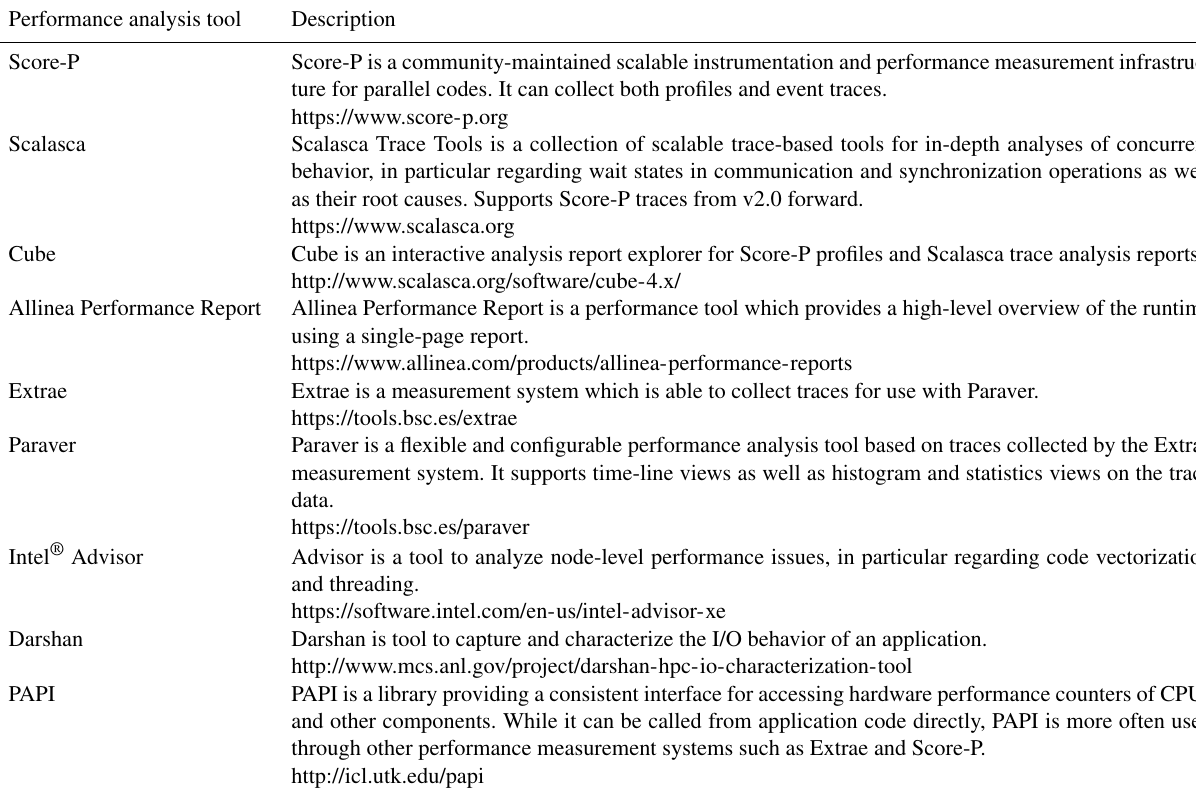
Table A1. Description of of the performance analysis tools currently supported by our